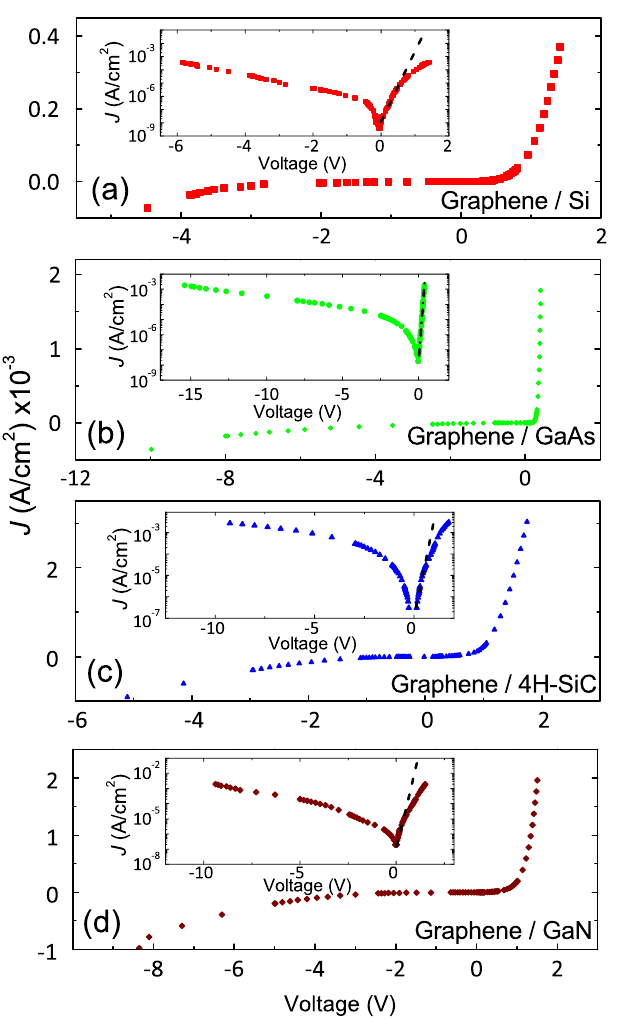
FIG. 5. Room-temperature current-density-voltage charac- teristics show Schottky rectification at the (a) graphene =n - Si , (b) graphene/ n -GaAs, (c) graphene/ n -4H-SiC, and (d) graphene/ n -GaN interfaces. Insets: Semilogarithmic plots, log J - V , reveal a thermionic-emission-dominated current den- sity in forward bias that spans at least two decades of linearity (dashed black lines), allowing us to extract the Schottky- barrier height that is recorded in Table I. The color codes for Fig. 5 are the same as those used for the curves in Fig.